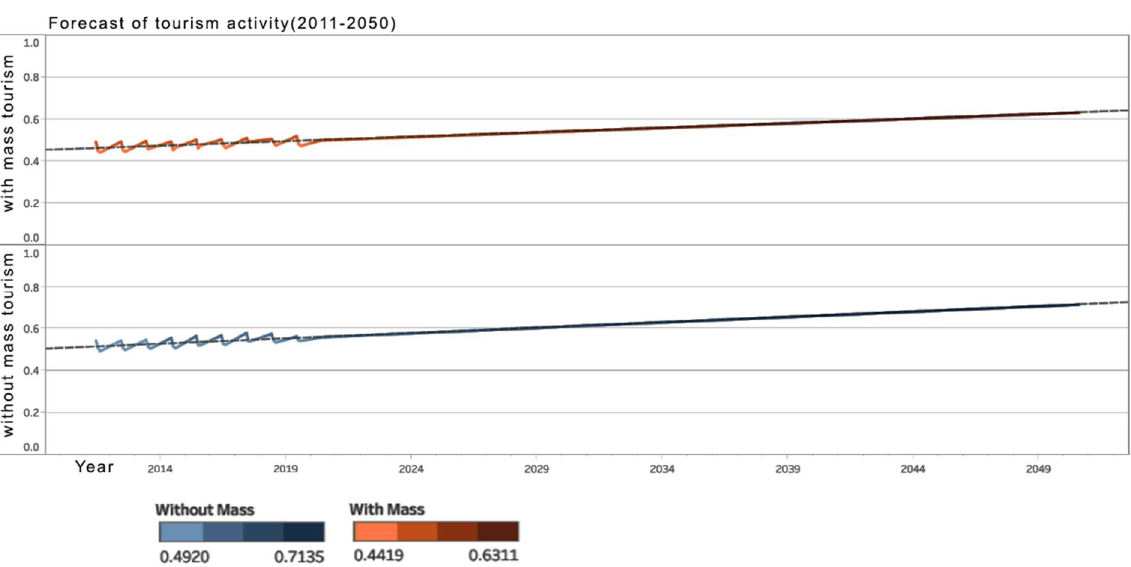
Figure 17. Analysis of indicator averages for the two scenarios.